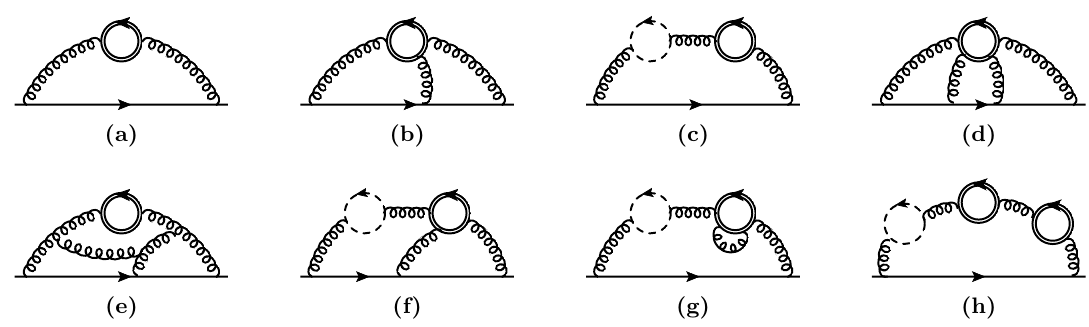
. Straight and curly lines represent m